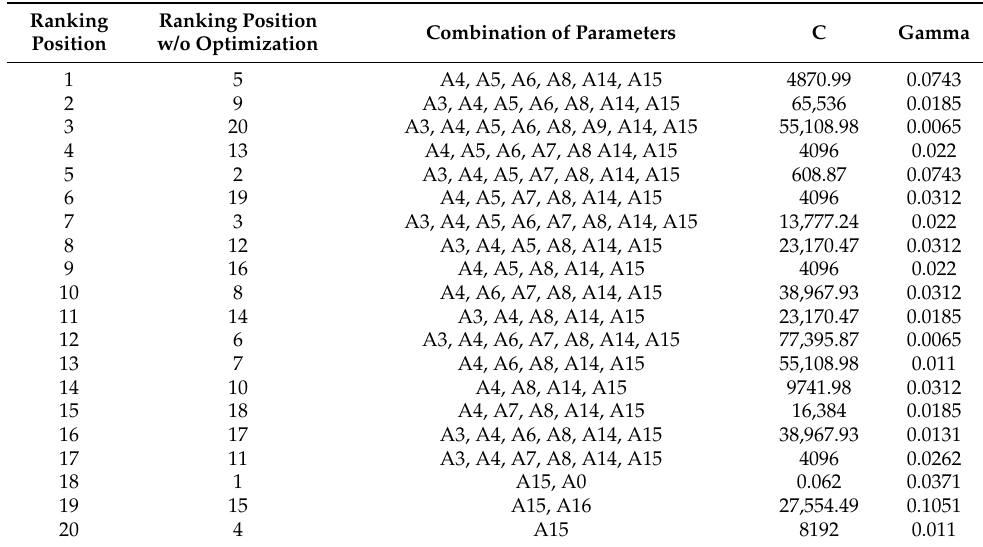
Table 6. Top 20 ranking for multiple wavelength usage for brown eggshells with hyperparameter optimization.